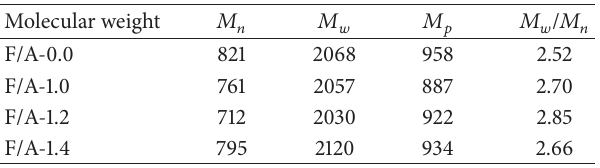
Table 7: The average molecular weights of asphalt mortar after UV aging.